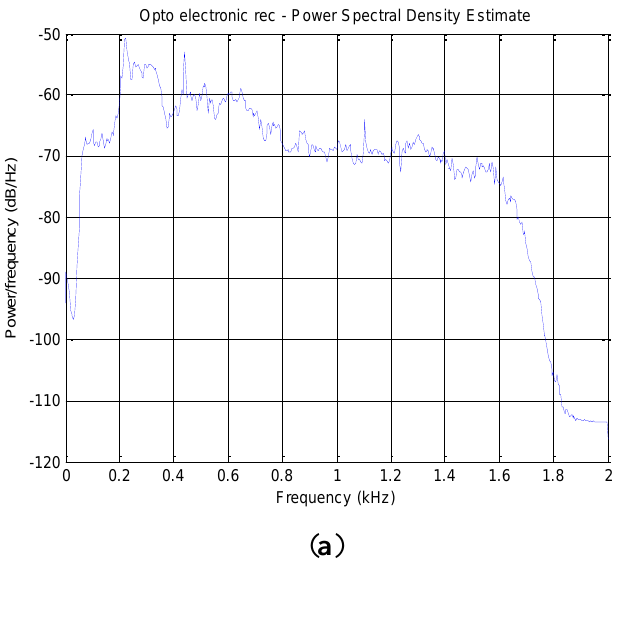
Figure 12. Power spectral densities of recordings of house-flies. ( a ) Recording from optoelectronic sensor; ( b ) Recording taken with a high quality microphone placed inside an insectary hosting 20